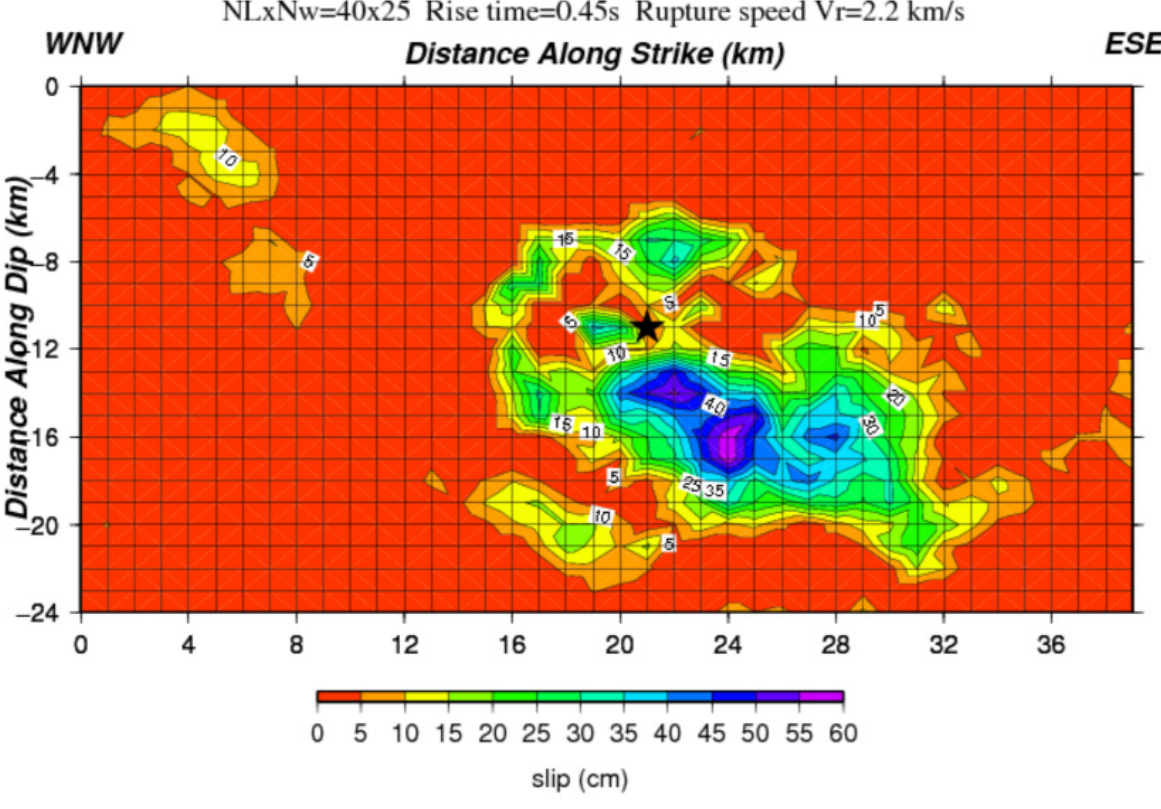
Figure 4. Slip distribution model for the 2012, M 6.1 Emilia mainshock. The contours are for 5 cm intervals of slip, beginning at 5 cm. Black star, adopted hypocentral